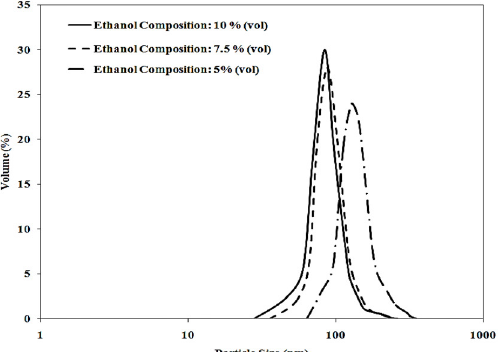
Fig. 4. Size distribution of paclitaxel particles obtained at 50˚C, 3 mL/min, DMSO/water ratio of 4 (v/v) and various ethanol concentrations of 5, 7.5 and 10%.